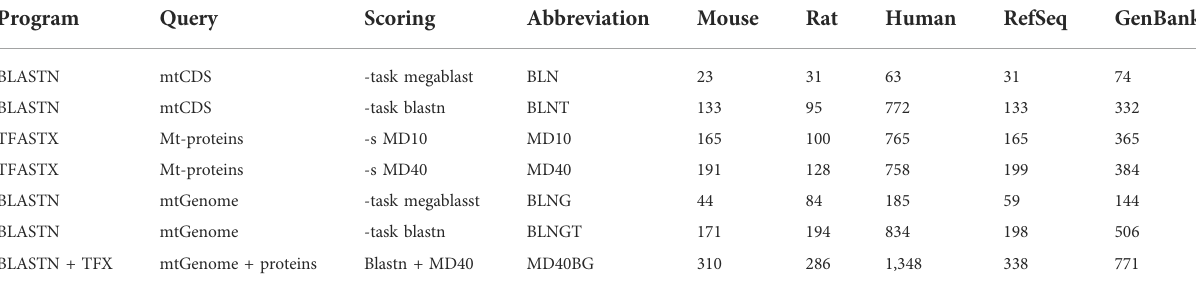
TABLE 1 Similarity searching strategies used in this study: program, query sequences, scoring matrix, abbreviations used within the text, the number of numts found in mouse, rat, human and the medians for rodent Refseq and GenBank genomes.